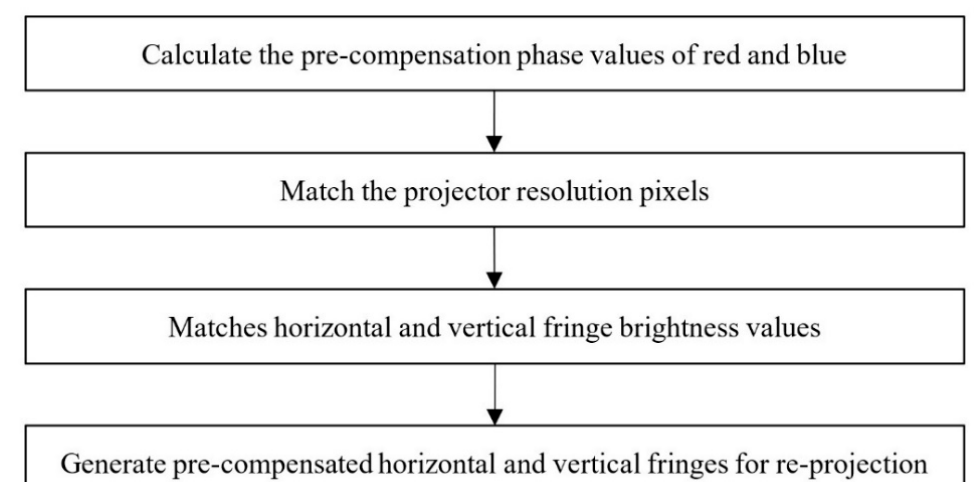
Figure 5. Flow chart of radial chromatic aberration correction.